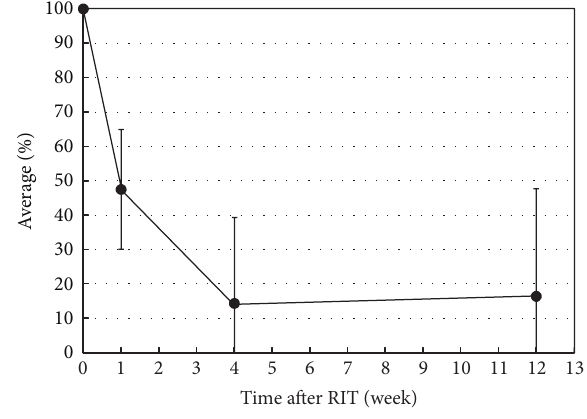
Figure 3: Average percent decrease in SUV baseline values as a function of time after RIT. Error bars represent standard deviations, with negative error bars on the 𝑦 -axis